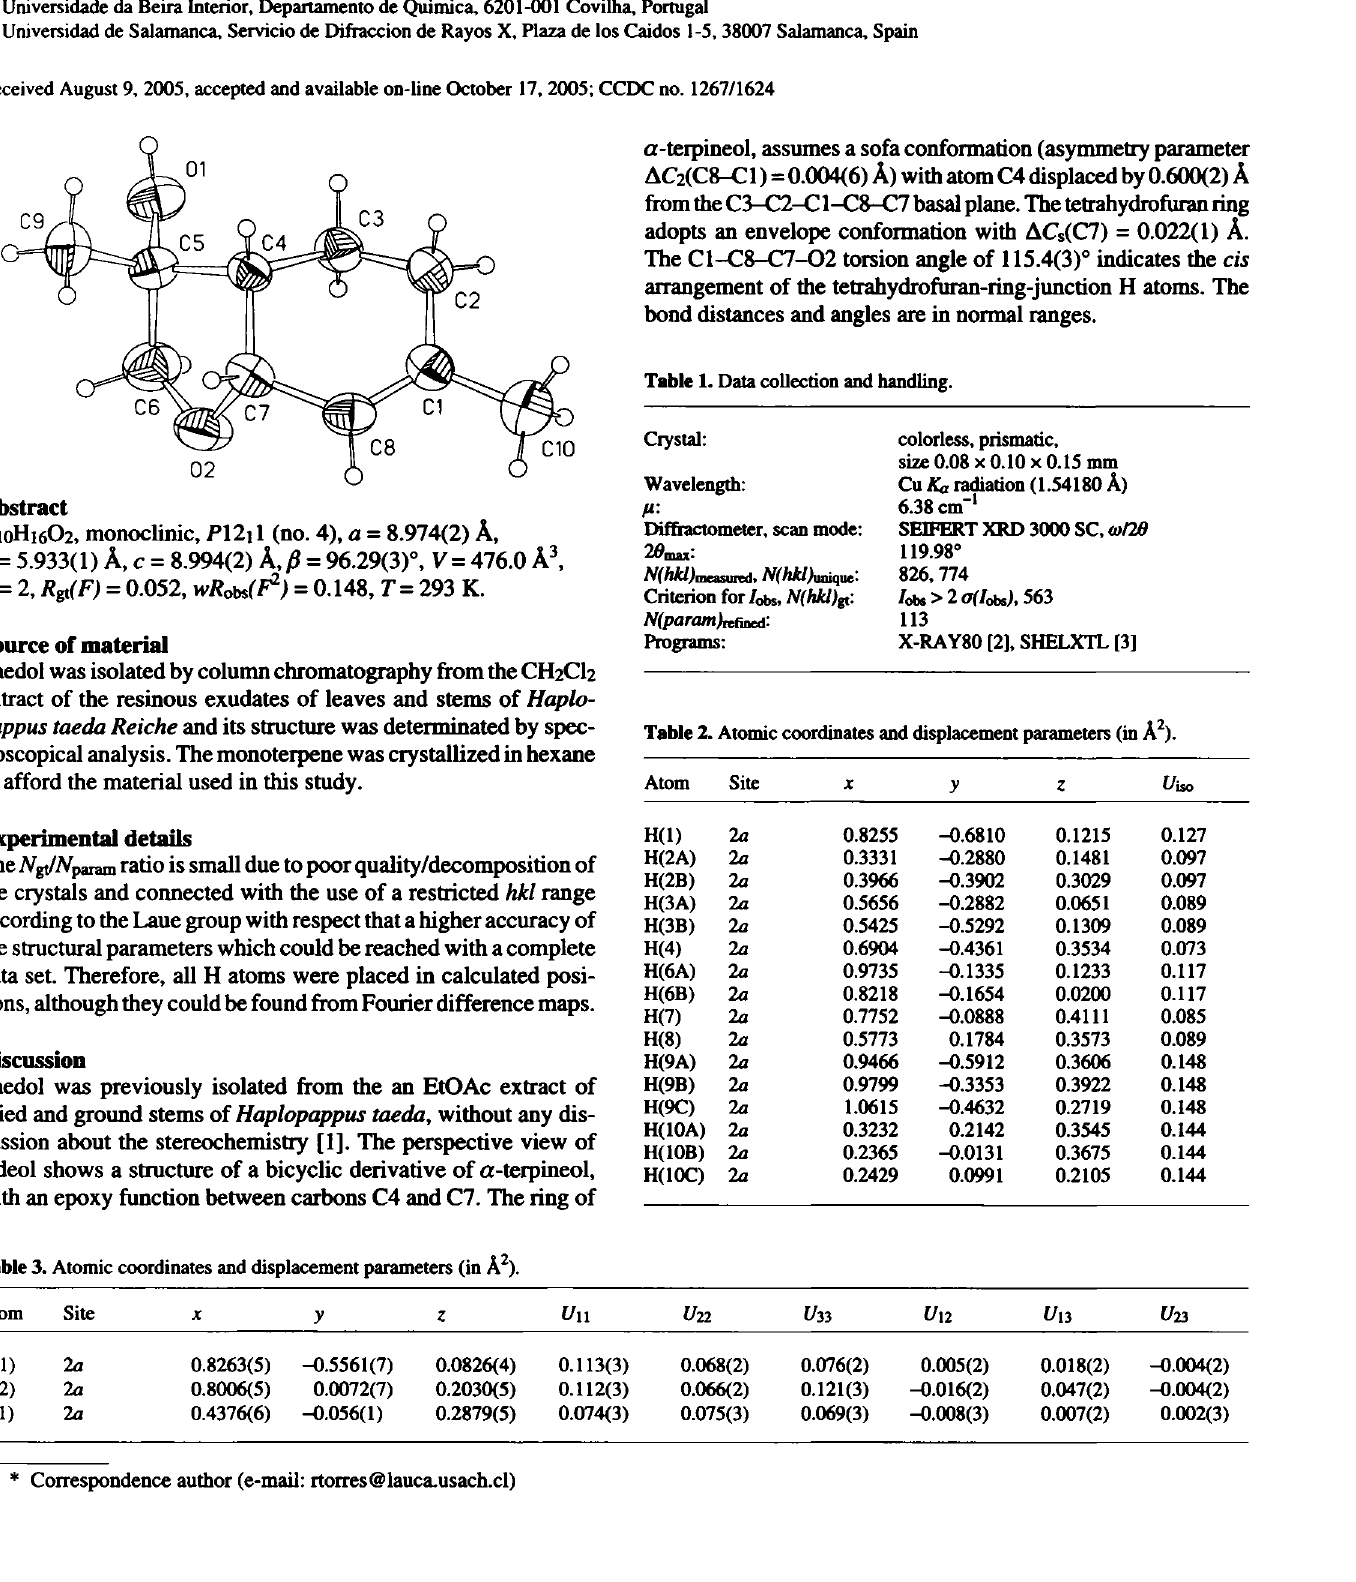
Table 3. Atomic coordinates and displacement parameters (in Ä 2